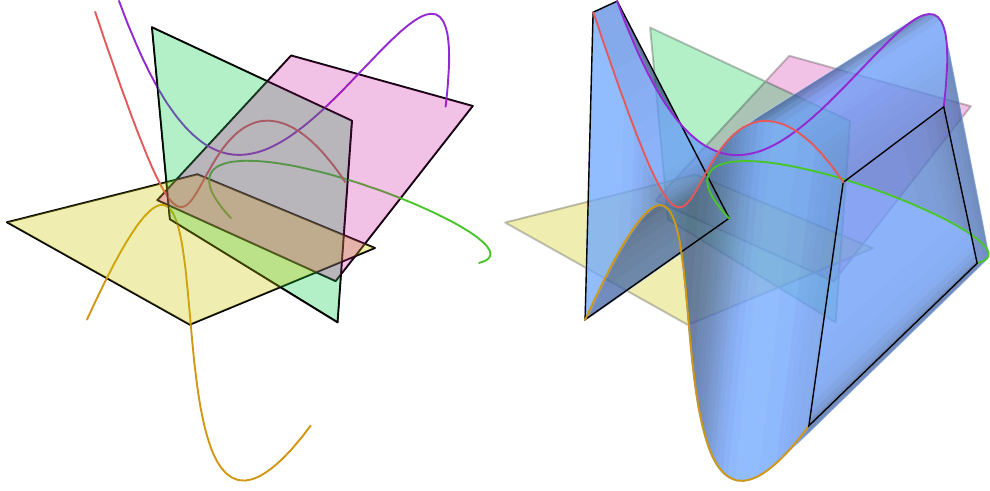
Figure 21. Four reflection mapped splines, three mirror planes, and the generated developable surfaces.